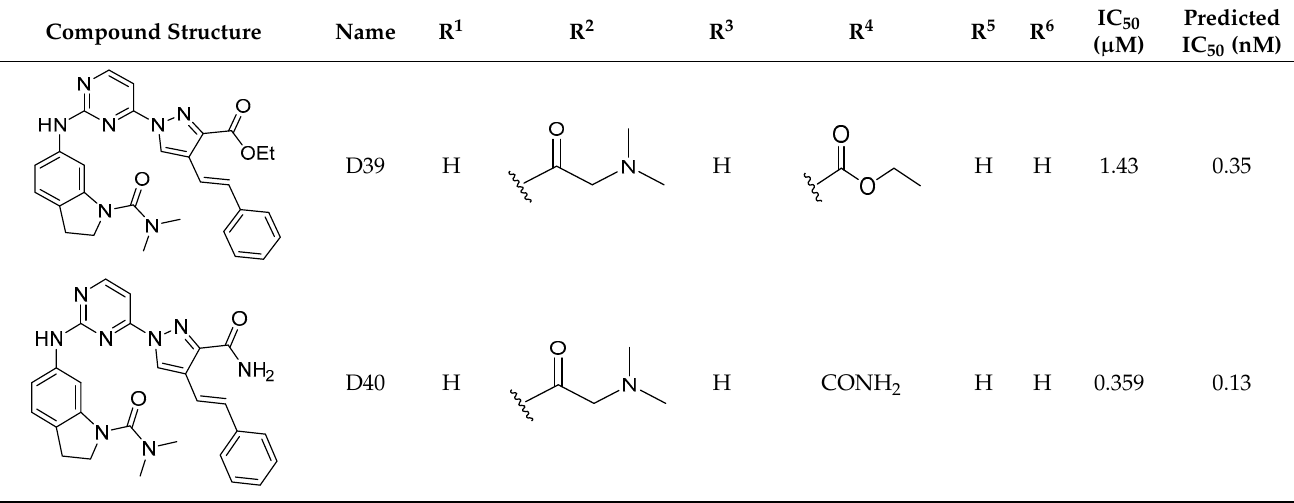
Table 3. The comparison of the actual and calculated IC 50 values of two synthesized PLK1 inhibitors.